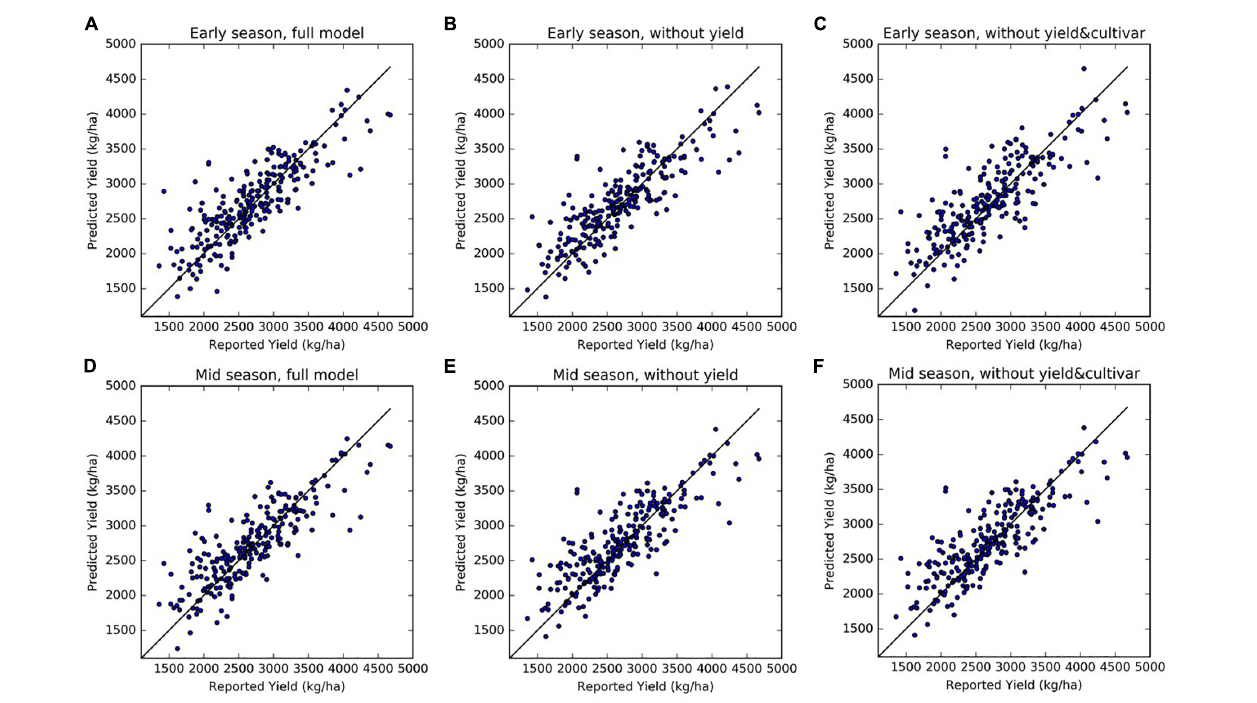
FIGURE 6 | Scatter plots of predicted vs. reported yields, from three sets of models for early season (top panels) and mid-season predictions (bottom panel): (A,D) full models, (B,E) reduced model excluding historical yields as predictors, and (C,F) reduced models excluding both historical yield and cultivar composition information. (A) : Early Full; (B) Early NoYld; (C) Early NoYld-NoCul; (D) : Mid-Full; (E) Mid-NoYld; (F) Mid-NoYld-NoCul. The predicted values shown here were from the reserved testing dataset in one round of the cross-validation ( N = 247).